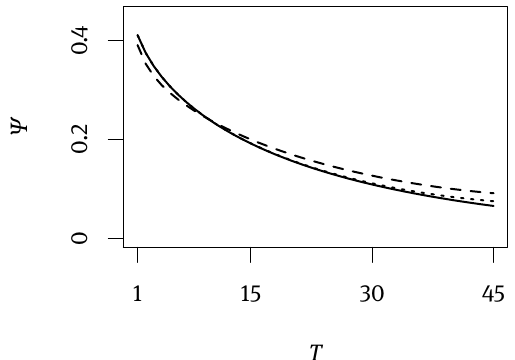
Figure 4: Probabilities of default for the equity model (solid line), the equity-longevity model (dotted line) and the complete model (dashed